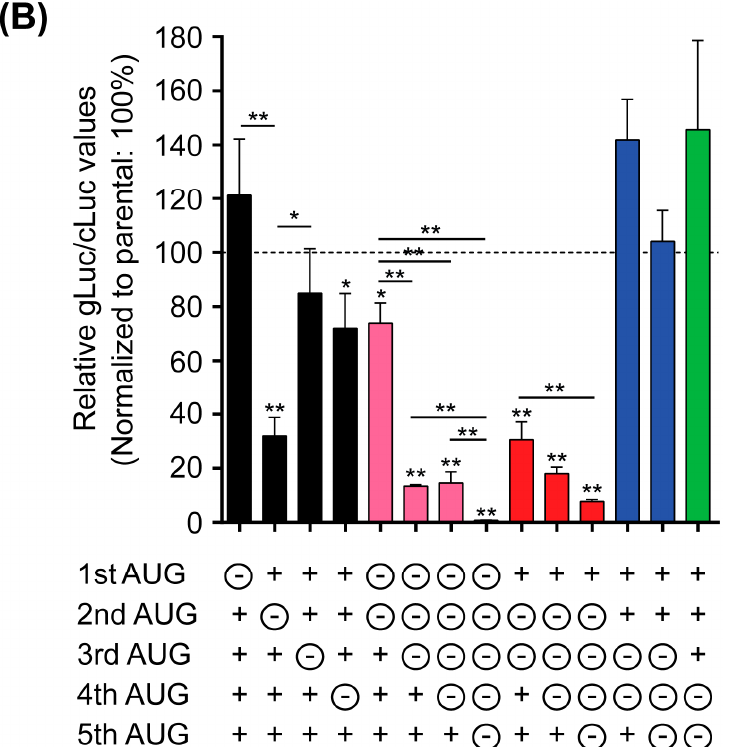
Figure 2. Relative expression of precursor proteins and cleaved Gn/gLuc fusion proteins after AUG abolishment. ( A ) Western blot of cell lysates. 293 cells were co-transfected with pSV40-CLuc (transfection control), and pCAGGS-PreGn-gLuc-SF or the AUG mutant plasmids. At 36 h post transfection, cell lysates were collected and analyzed by Western blot using anti-Flag antibody; ( B ) the extracellular Gn/gLuc fusion proteins were measured using the culture supernatant of transfected cells. The ratio of gLuc to cLuc (control plasmid) was normalized to that of parental pCAGGS-PreGn-gLuc-SF. The graph represents the mean + the standard error of three independent experiments. Asterisks represent statistically significant differences (one-way ANOVA followed by Tukey’s multiple comparisons test, * p < 0.05, ** p < 0.01). Asterisks shown on error bars represent the comparison with compared to the Δ 4 + 5 mutant.